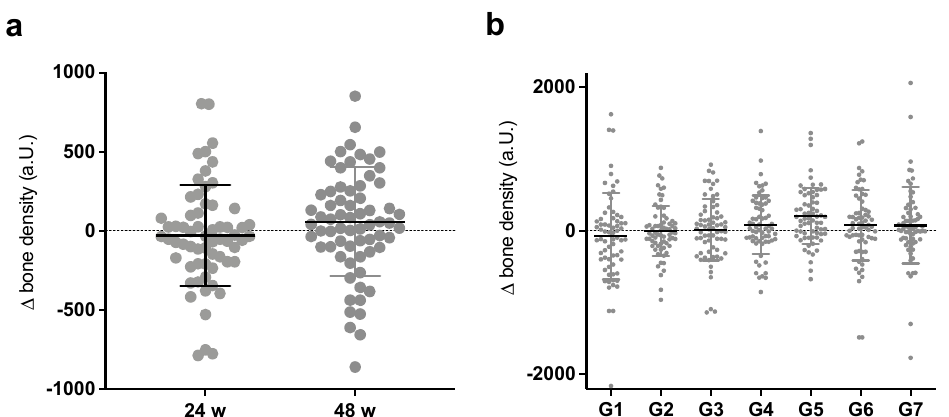
Figure 3. ( a ) Average ∆ -density after 24 and 48 weeks; ( b ) averages G1 to G7 after 48 weeks. There was non-significant mean density deterioration after 24 weeks and improvement after 48 weeks with increasing outliers over time, as some stems showed progressive loosening or stress shielding, while others showed good bone remodeling and solid ingrowth. Thereby, clear differences could be seen for the Gruen zones with the strongest outliers and widest spreads in both directions in proximal areas and the least changes in distal areas.